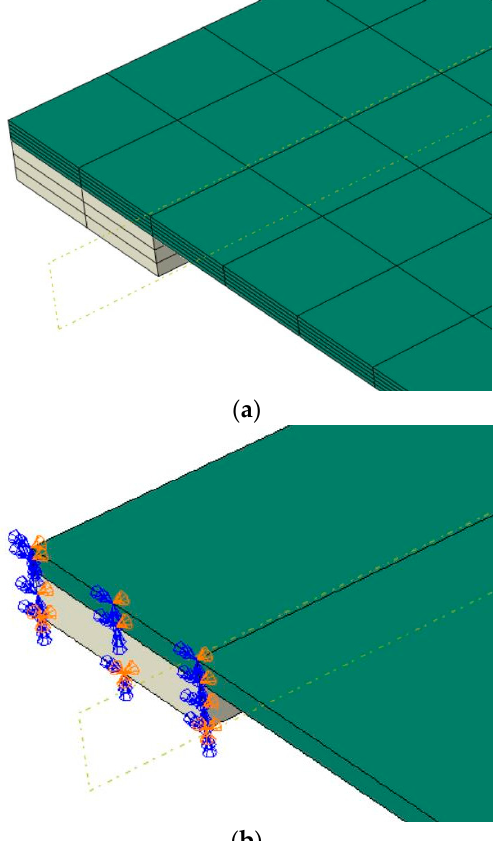
Figure 9. FE numerical model (ABAQUS/Standard): ( a ) assembly detail at the edges (hidden mesh) and ( b ) restraints.